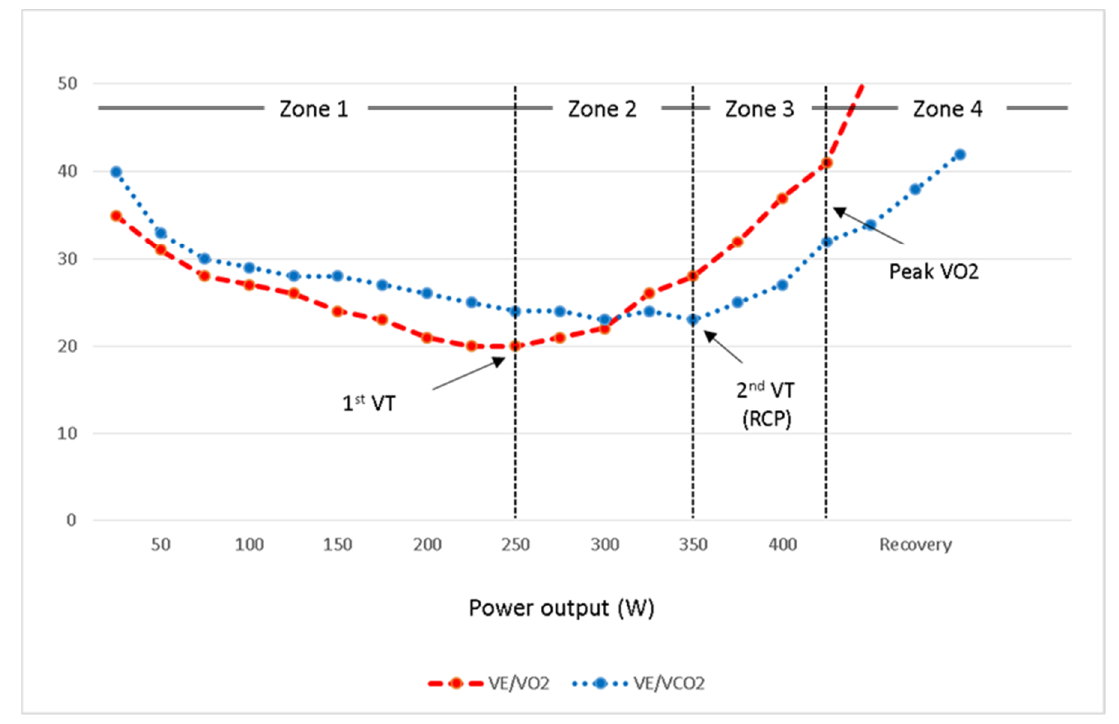
Figure 2. The ventilatory equivalents for oxygen (VE/VO 2 ) and carbon dioxide (VE/VCO 2 ) and their association with first and second VT which form four training zones during an incremental CPET. VT: ventilatory threshold, RCP: respiratory compensation point.